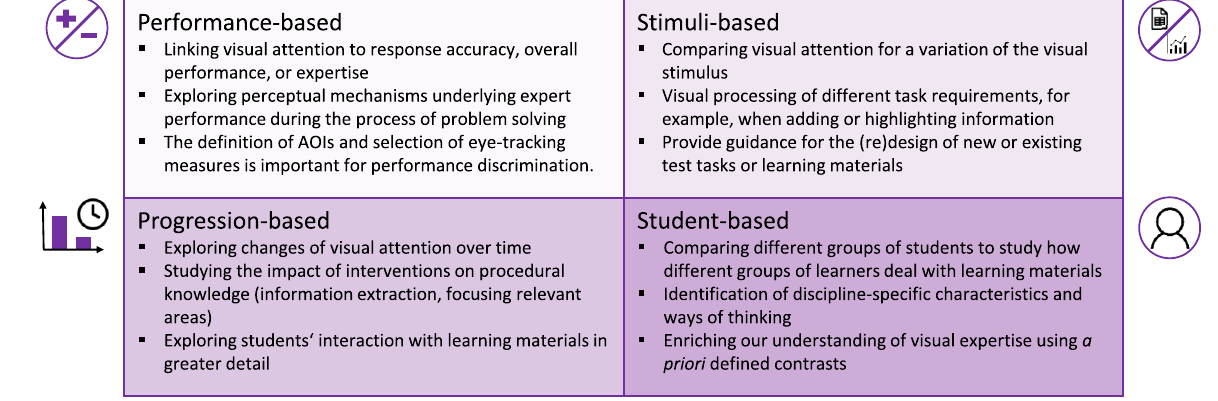
FIG. 5. Overview of the most frequent independent variables for which the eye-tracking metrics have been evaluated and their